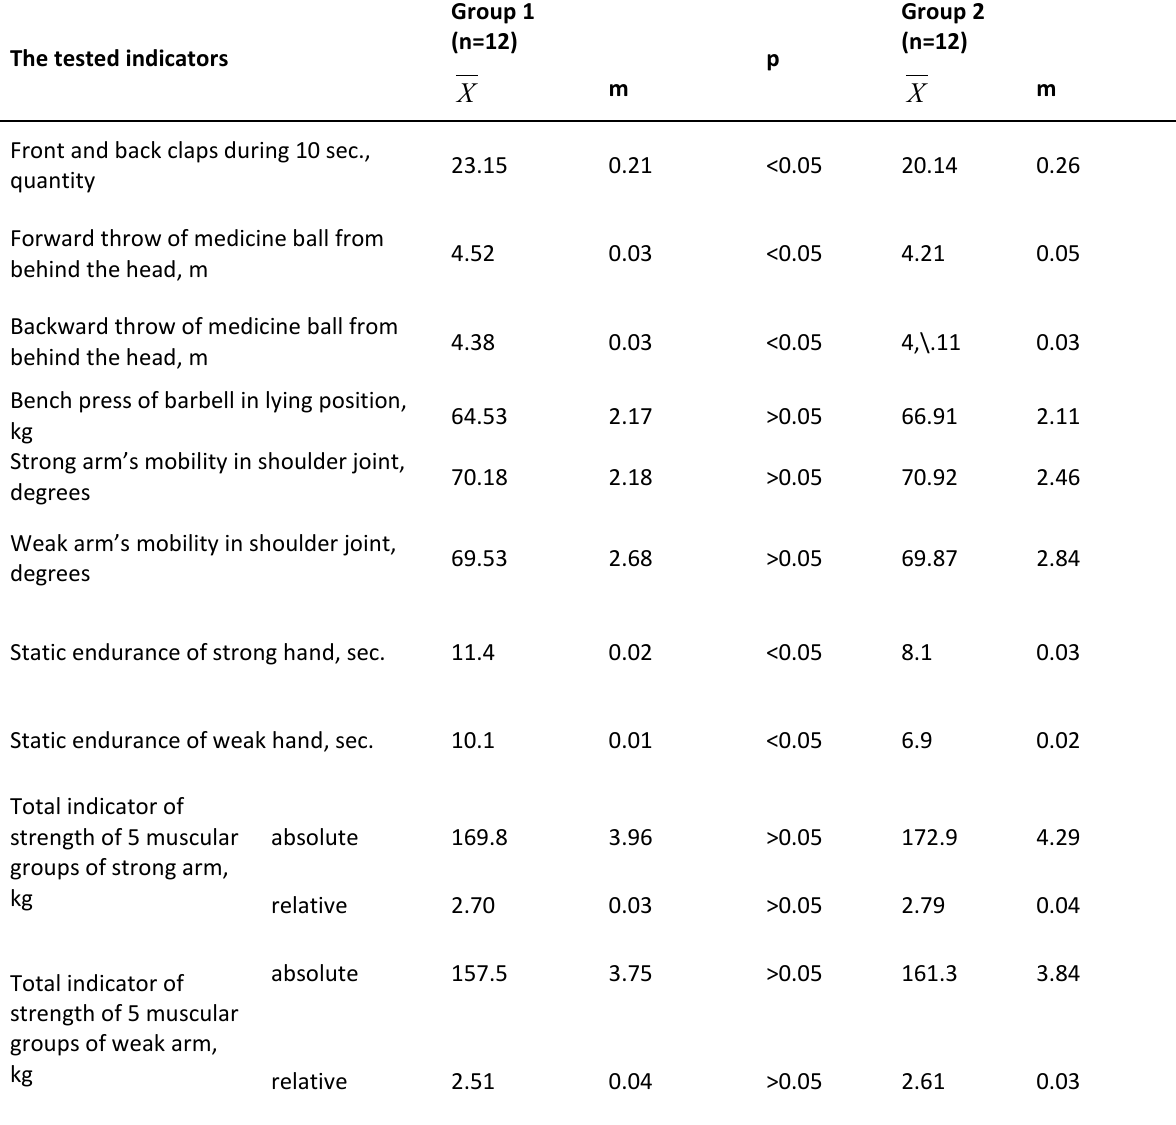
Table 2. Sport results and motor qualities indicators of students – power lifters with MSA disorders in group 1 and 2 at the end of